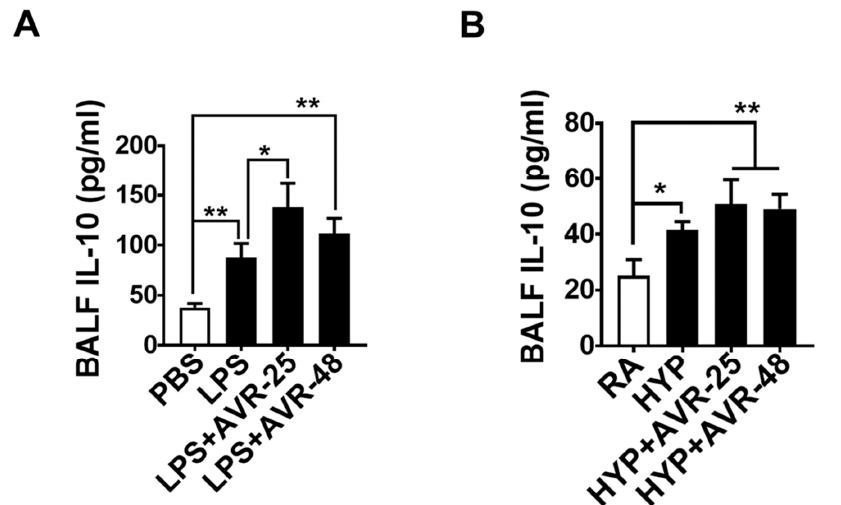
Figure 2. AVR-25 or AVR-48 treatment enhances anti-inflammatory cytokine in LPS- and hyperoxia- induced ALI mice. ( A , B ) ELISA assay for the levels of anti-inflammatory cytokine IL-10 in the BALF ( n = 5–6, * p < 0.05 and ** p < 0.01). Data are expressed as mean ± SEM. For statistical analysis, student’s unpaired t -test and one-way analysis of variance (ANOVA) followed by Tukey post hoc analysis were used. LPS: lipopolysaccharide; ALI: acute lung injury; BALF: bronchoalveolar lavage fluid; IL: interleukin; PBS: phosphate buffered saline; RA: room air; HYP: hyperoxia. 2.6. Effect of AVR-25 and AVR-48 on Pulmonary Vascular Leakage in ALI Mice